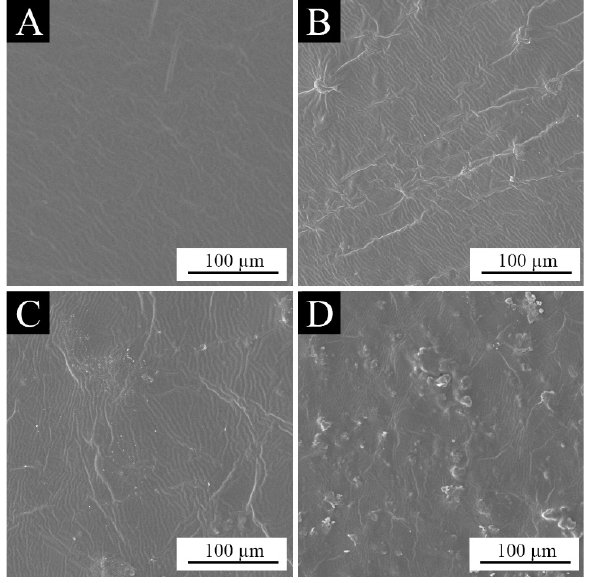
Figure 8. SEM images of the paint films: ( A ) 0% microcapsule ‐ loaded film, ( B ) 3.0% microcapsule ‐ loaded film, ( C ) 6.0% microcapsule ‐ loaded film and ( D ) 12.0% microcapsule ‐ loaded film.